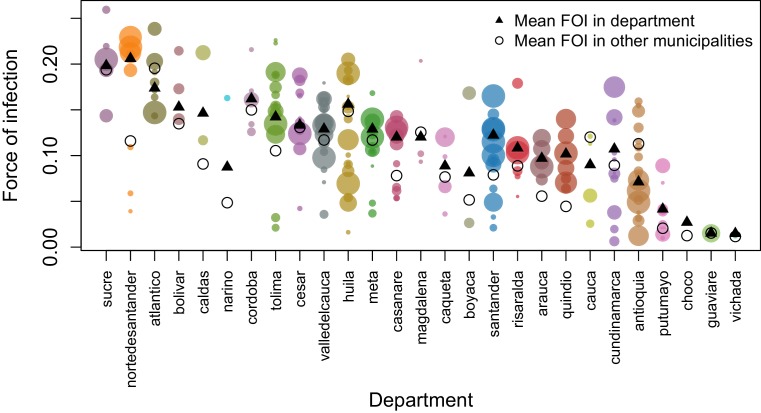
Heterogeneity in FOI within administrative level 1 units of Colombia.Filled circles show the estimates for each municipality (administrative level two unit) within the department that reported > 200 cases. Hollow circles indicate the mean force of infection for those municipalities that reported < 200 cases. Size of circles is proportional to the number of cases available to estimate the FOI. Triangles indicate the mean estimate for each department.